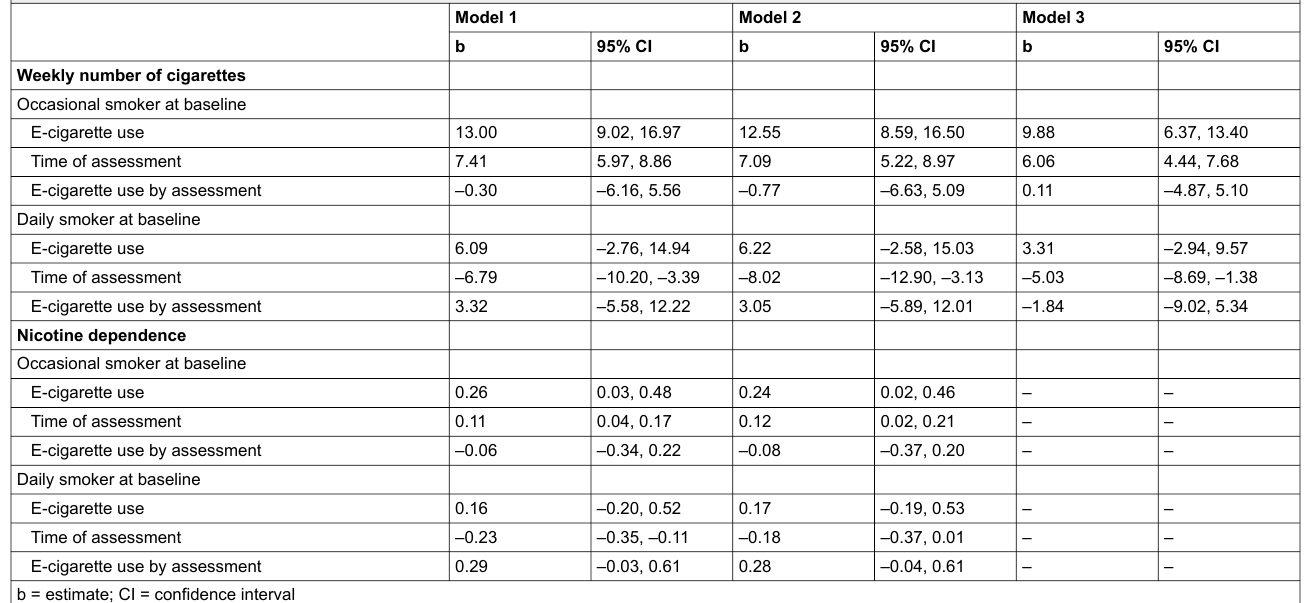
Table 4: Results of mixed models for weekly number of cigarettes and nicotine dependence, Switzerland 2010–2013.